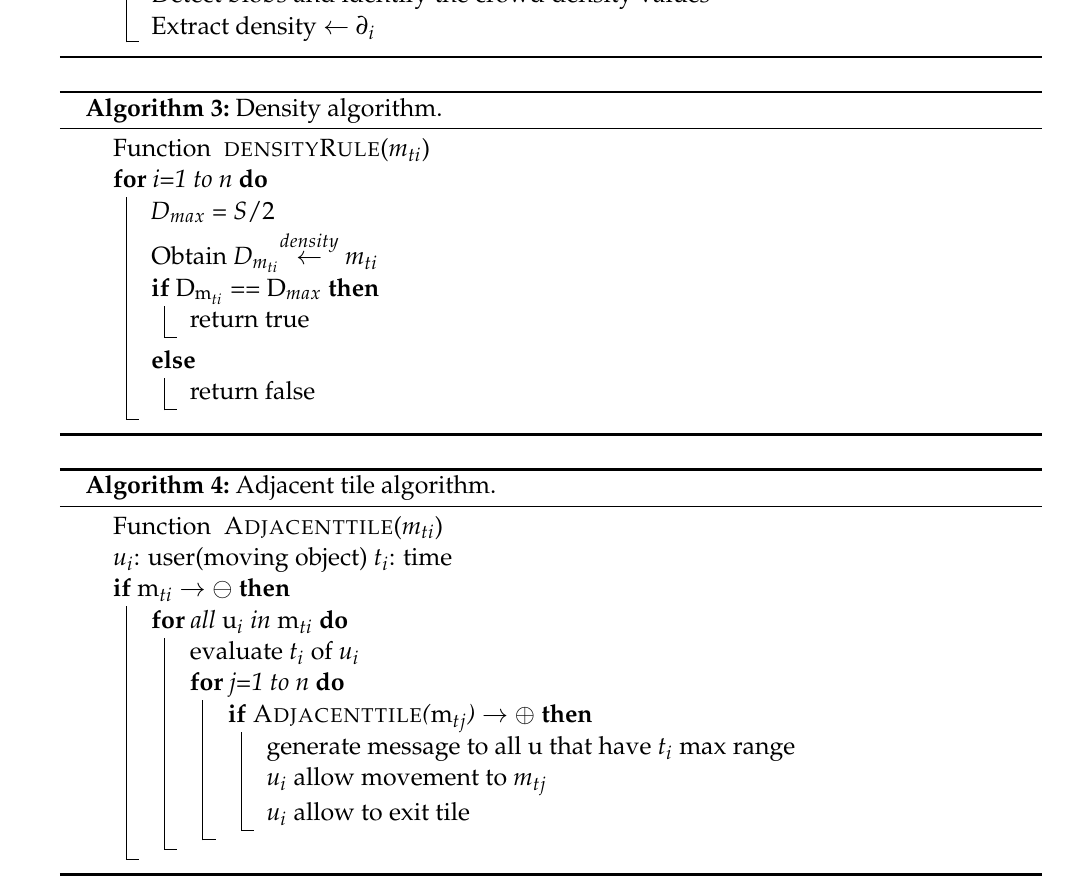
Algorithm 4: Adjacent tile